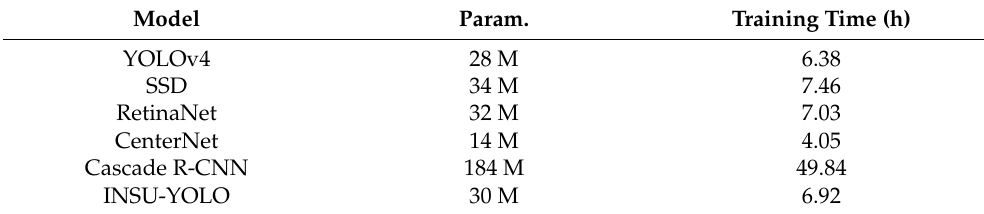
Table 11. Network parameters (Param.) and training time of the different models.